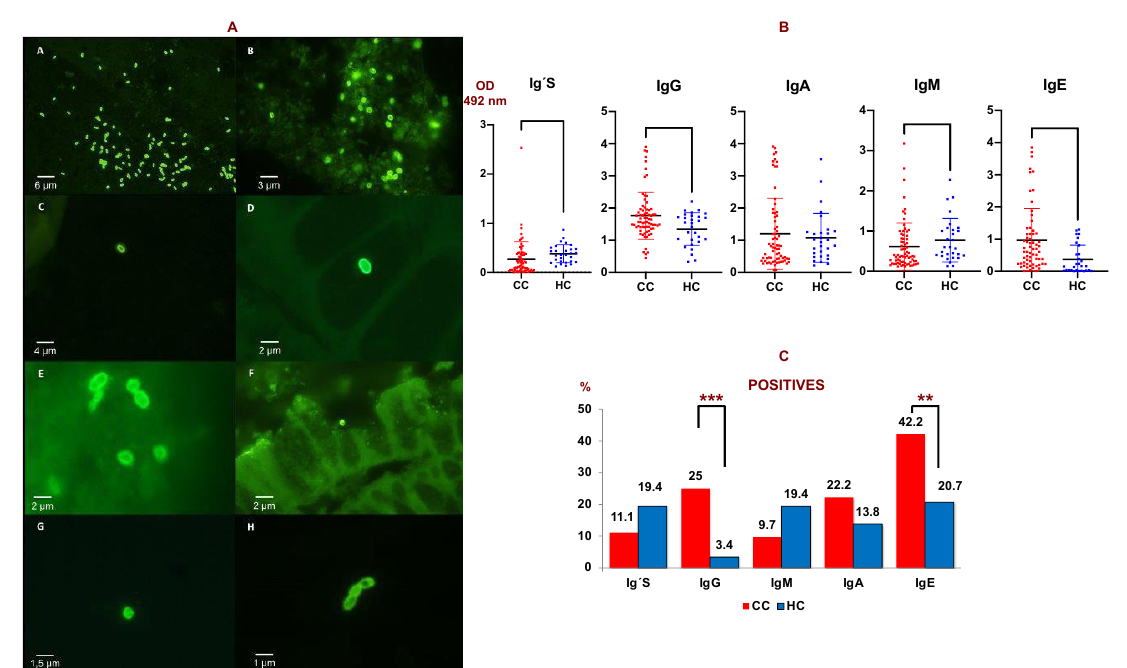
Figure 1. ( A ) IFAT of microsporidia species. A: Positive control of MAb 2C2 with purified spores of E. cuniculi (40×); B: Positive control of MAb 6E52D9 with spores of E. bieneusi (100×); C: Spores of Encephalitozoon sp. in positive biopsies by IFAT with MAb 2C2 (40×); D and E: Spores of Encephalito- zoon sp. in positive biopsies by IFAT with MAb 2C2 (100×); F: Spore of E. bieneusi in positive biopsies by IFAT with MAb 6E52D9 (40×). G and H: Spores of E. bieneusi in positive biopsies by IFAT with MAb 6E52D9 (100×). ( B ) Anti- E. cuniculi antibody levels (O.D. = optical density) measured by ELISA in colon cancer patients (CC, N = 87) and healthy controls (H, N = 25). Ig ’ s: total immunoglobulins. ( C ) Percentage of serum samples considered as positive against E. cuniculi in colon cancer patients (CC) compared to healthy controls (HC) obtained by ELISA. Ig´s: total immunoglobulins. Double T bars denote standard deviation (*** p < 0.001, ** p < 0.01). A Mann-Whitney U test was used. Table 2. Microsporidia species detection in CC patient tissue ( N = 87).